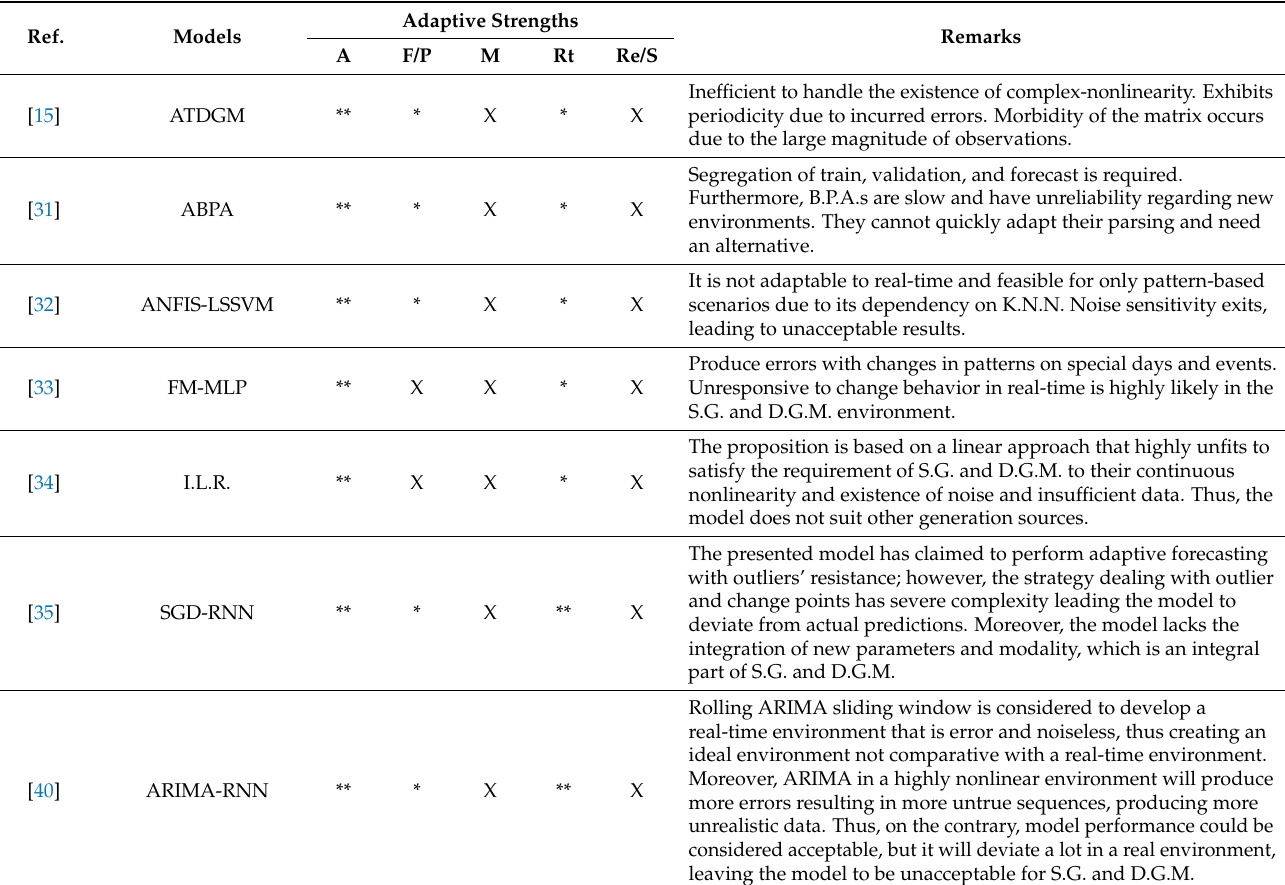
Table 1. Summary of the comparative study of a+daptive E.L.F. models based on their strengths.